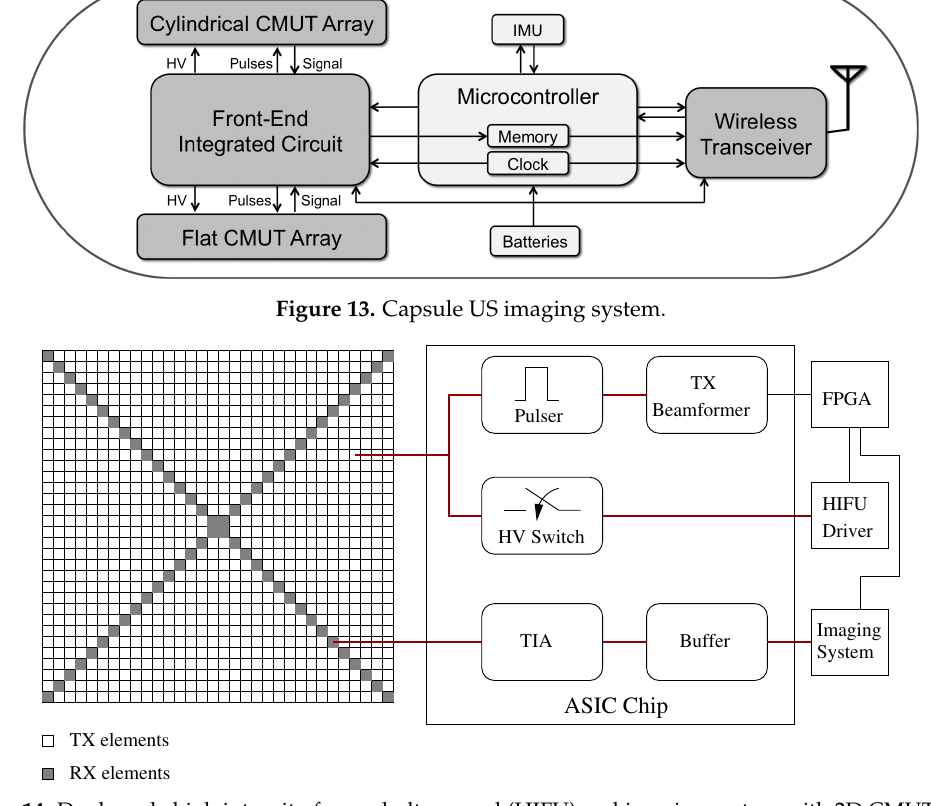
Figure 14. Dual-mode high intensity focused ultrasound (HIFU) and imaging system with 2D CMUT array and electronic circuitry